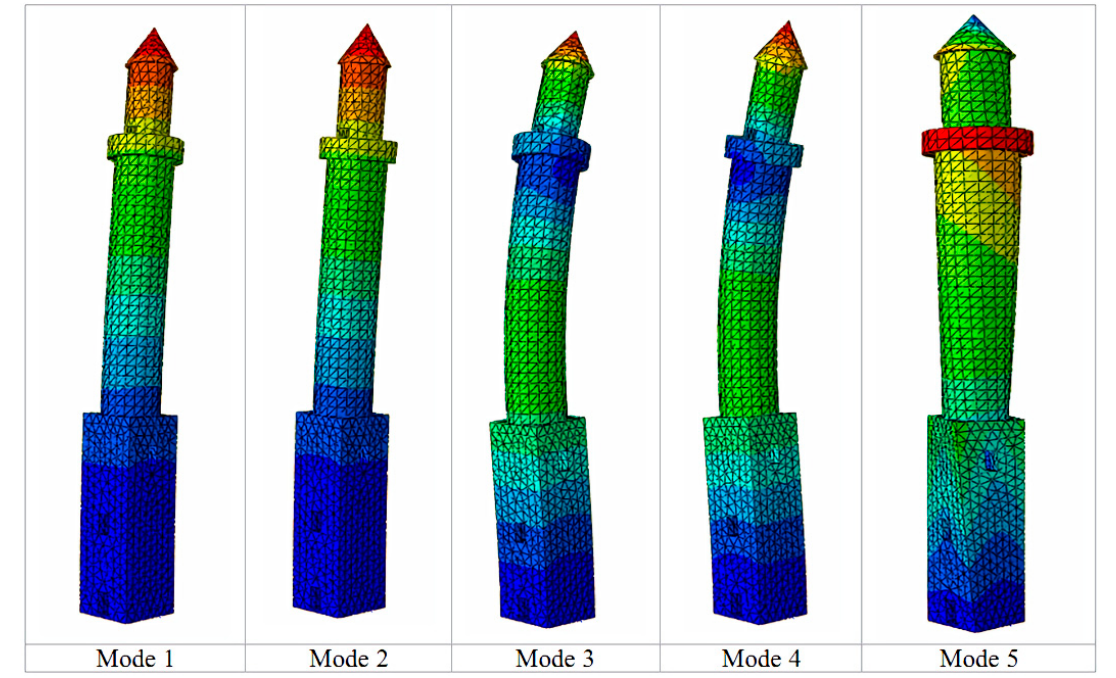
Figure 20. Mode shapes fort the first five modes.